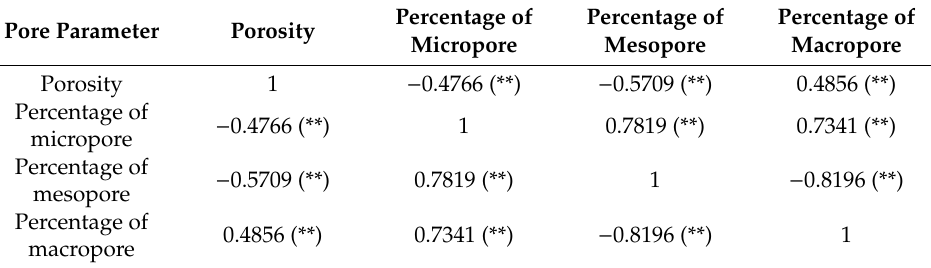
Table 8. Analysis of pore volume